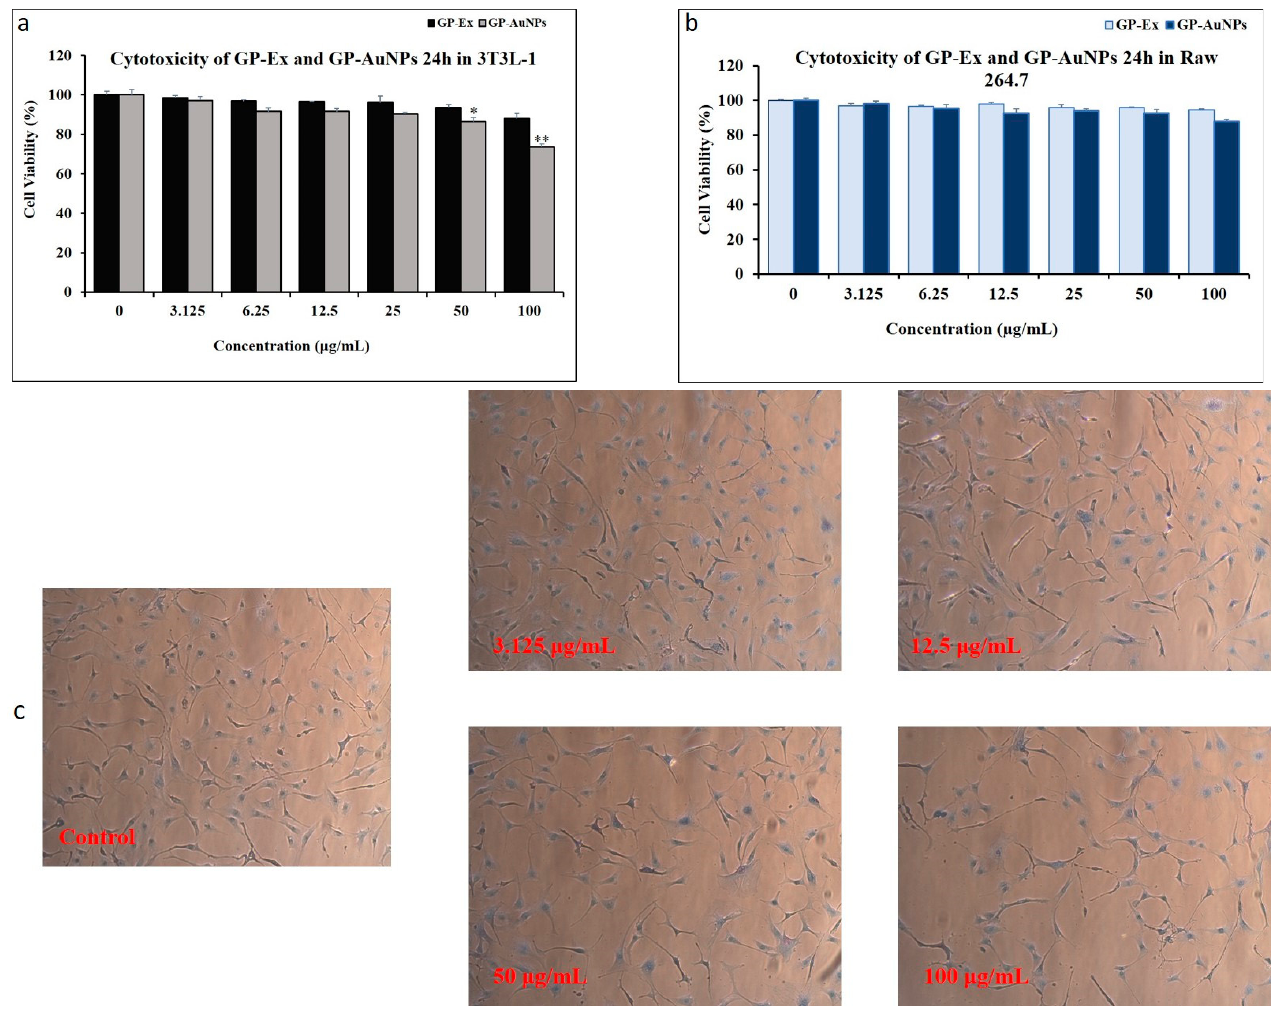
Figure 6. Cell viability of 3T3-L1 cell line on treatment with ( a ) GP extract and GP-AuNPs for 24 h. ( b ) GP extract and GP-AuNPs on Raw 264.7 cell viability for 24 h. ( c ) Trypan blue cell viability images before and after treatment with GP-AuNPs on 3T3-L1 cells. Each set of data represents the mean of triplicate experiment ± standard deviation. A significant difference between the groups was calculated using a two-tailed Student’s t -test. * < 0.05, ** p < 0.01 vs. control is used to represent a significant difference in cell viability of the sample compared with a nontreated control group.